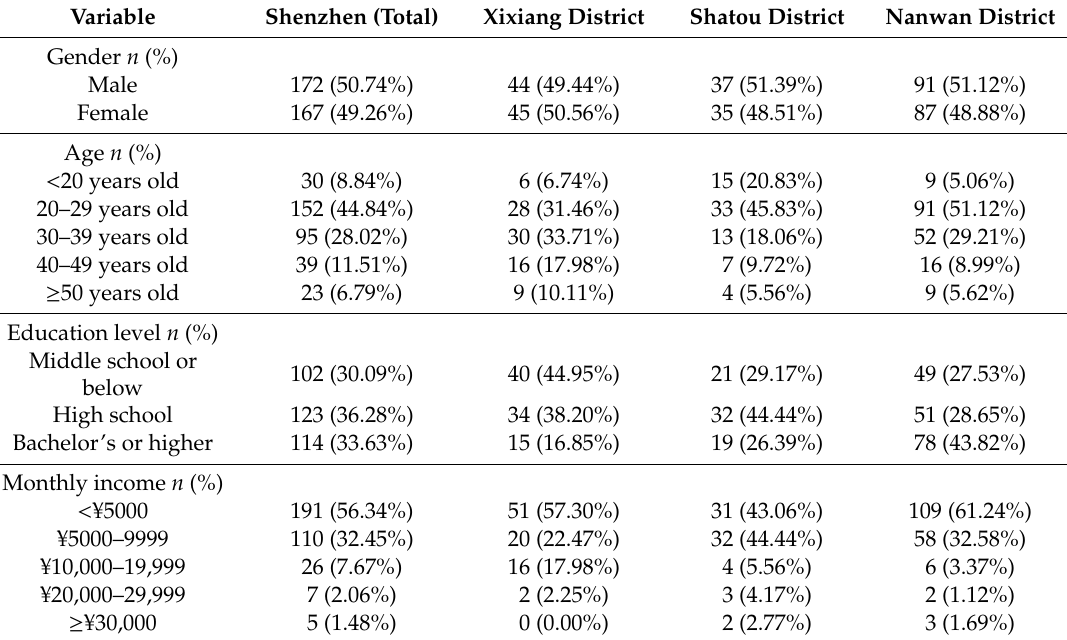
Table 2. Sociodemographic attributes of